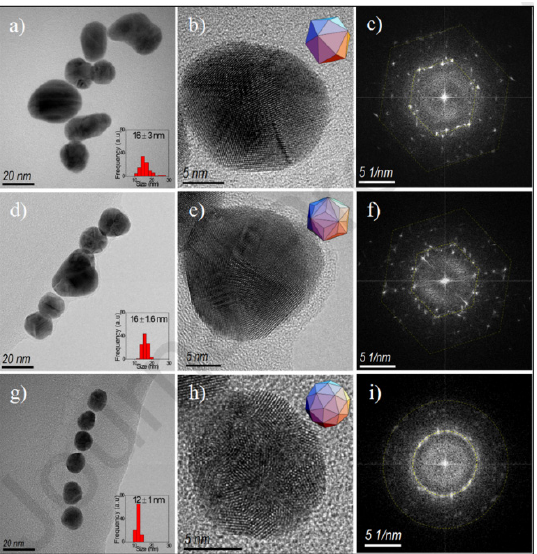
Figure 3. The TEM images of AuNPs are shown in the first column—( a , d , g )—with graphs of size distribution shown in the insets. The HRTEM images in the second column—( b , e , h )—are polyhedral insets. We can see the SAEDs in the third column—( c , f , i ) [60]. Copyright Elsevier 2021.